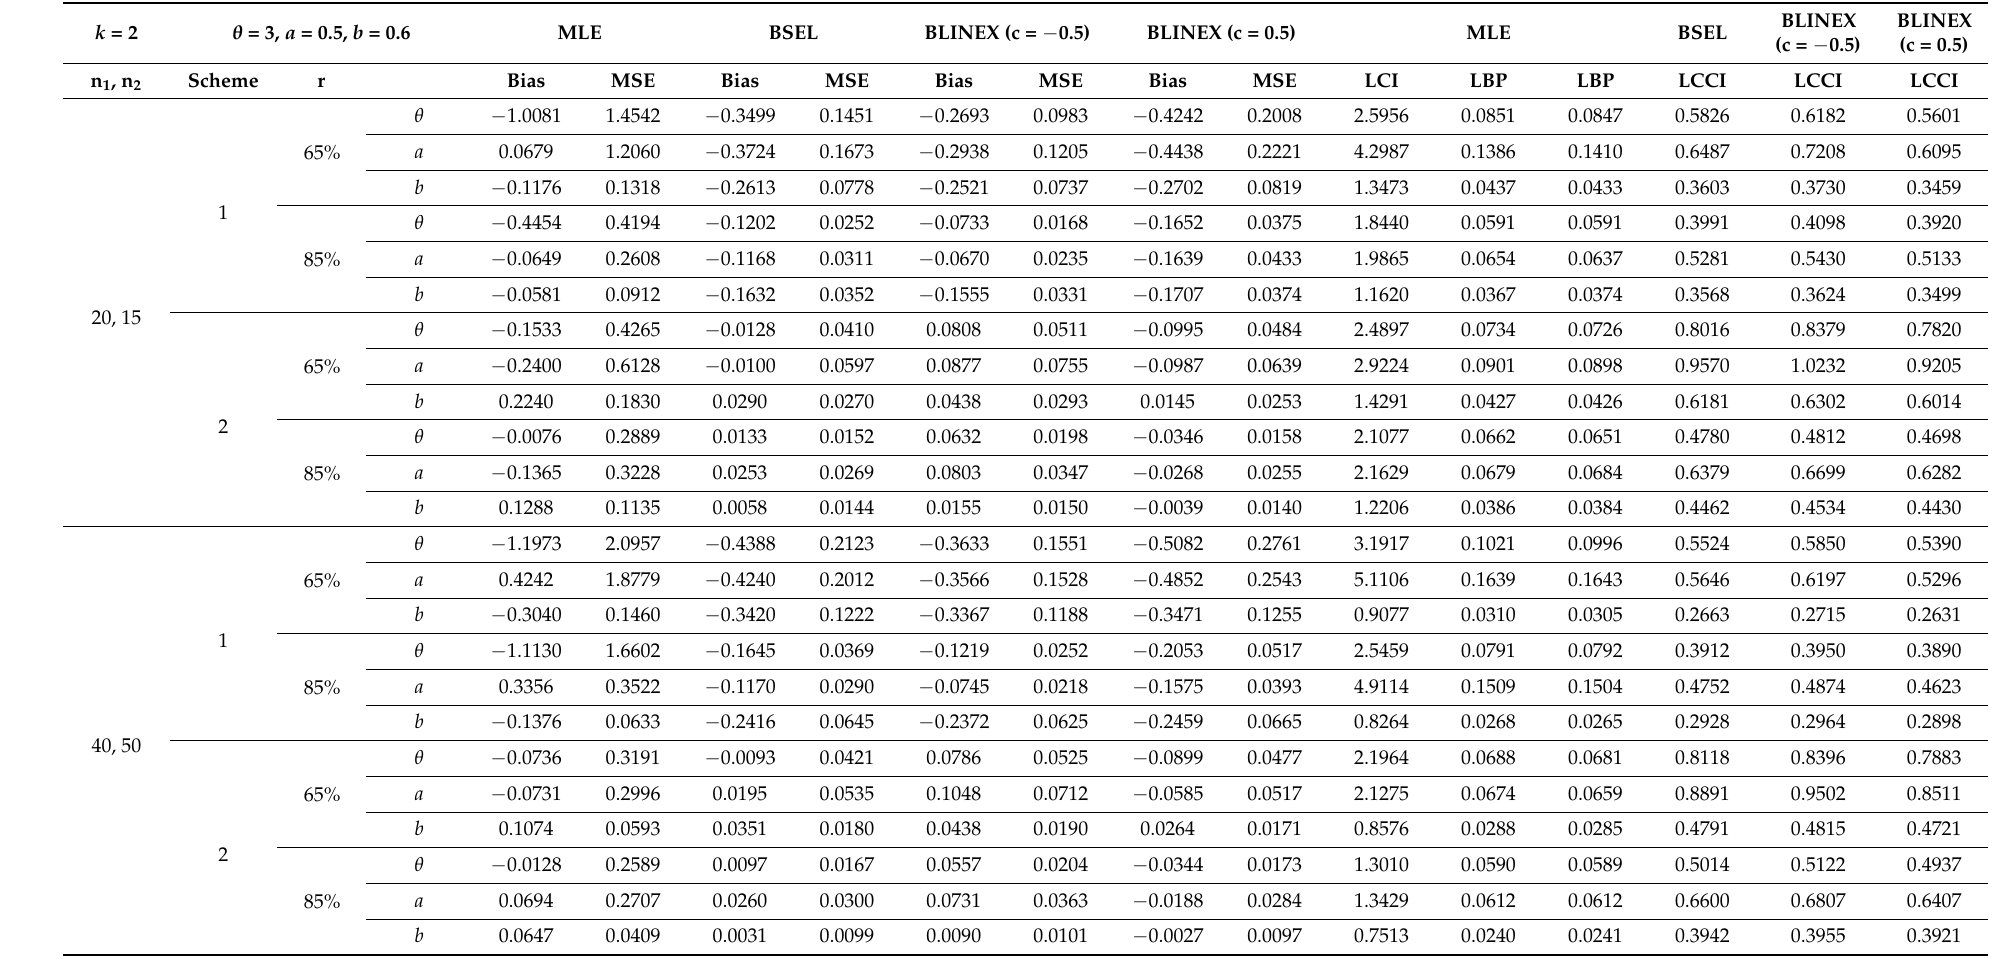
Table 3. MLE and Bayesian estimation with different loss functions in the simple ramp when θ = 3, a = 2.5, b = 0.6. k = 2 θ = 3, a = 0.5, b =